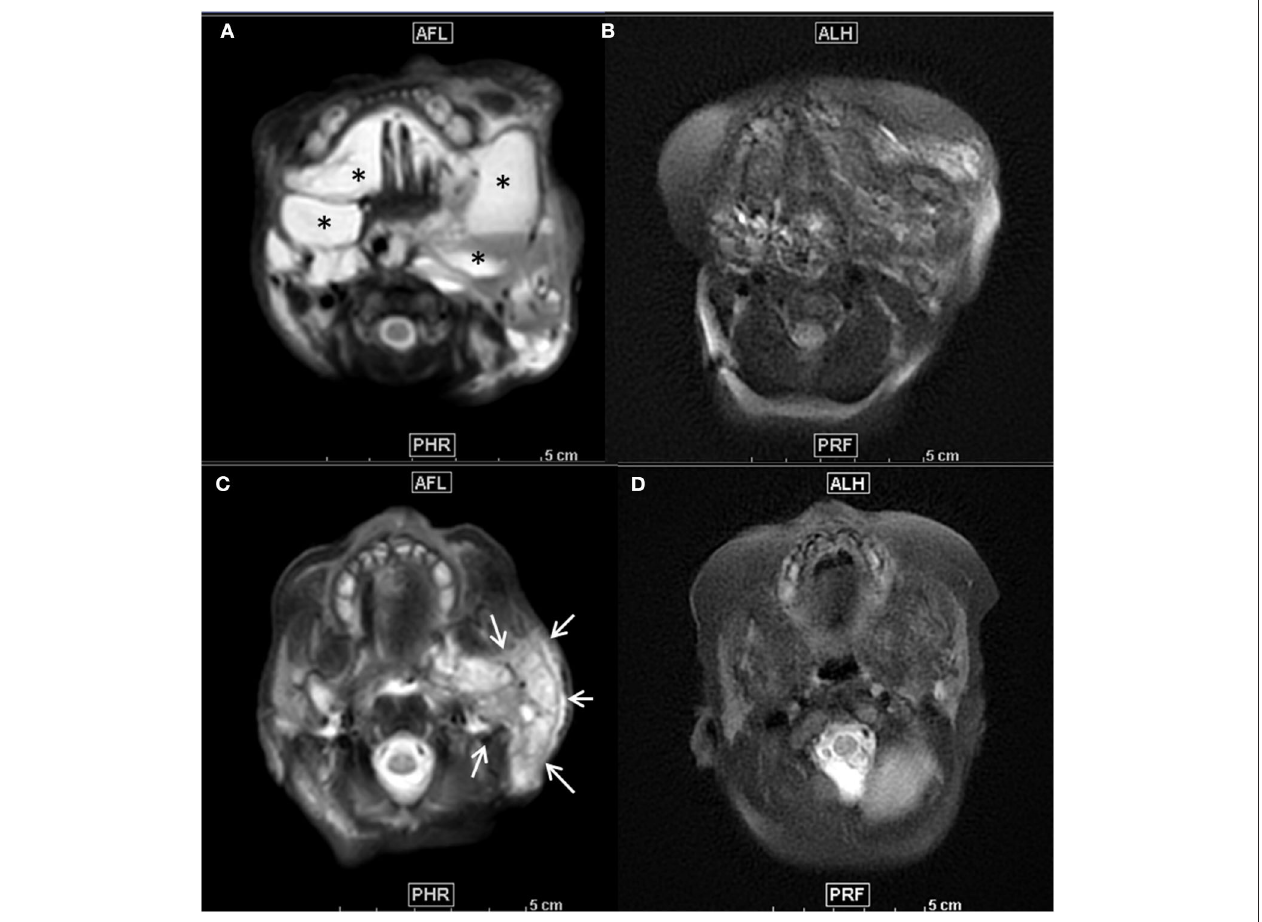
FIGURE 2 | (A–D) Axial T2-weighted fat suppressed MR images before treatment (A,C) showed mixed macro- and microcystic extensive cervico-facial lymphatic malformation with diffuse involvement of the sublingual space and both cheeks by large macrocysts (*) (A) and extensive infiltration of the left parotid space by a large microcystic component, as demonstrated by the diffuse T2 hyperintensity of the whole left parotic space (arrows) (C) . Seven months after initiation of the Sirolimus and after 3 percutaneous procedures of sclerotherapy, follow-up axial T2 weighted images at the same anatomical levels (B,D) demonstrated a major decrease of both macrocysts (B) and microcystic infiltration as demonstrated by the important decrease of T2 intensity of the parotid space (D)